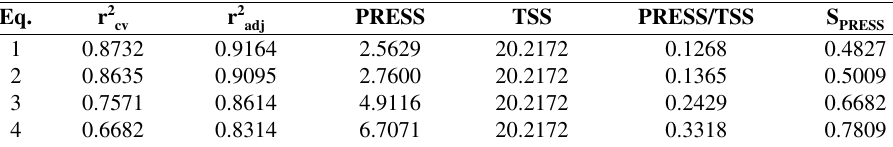
Table 5. Cross -validation parameters for models